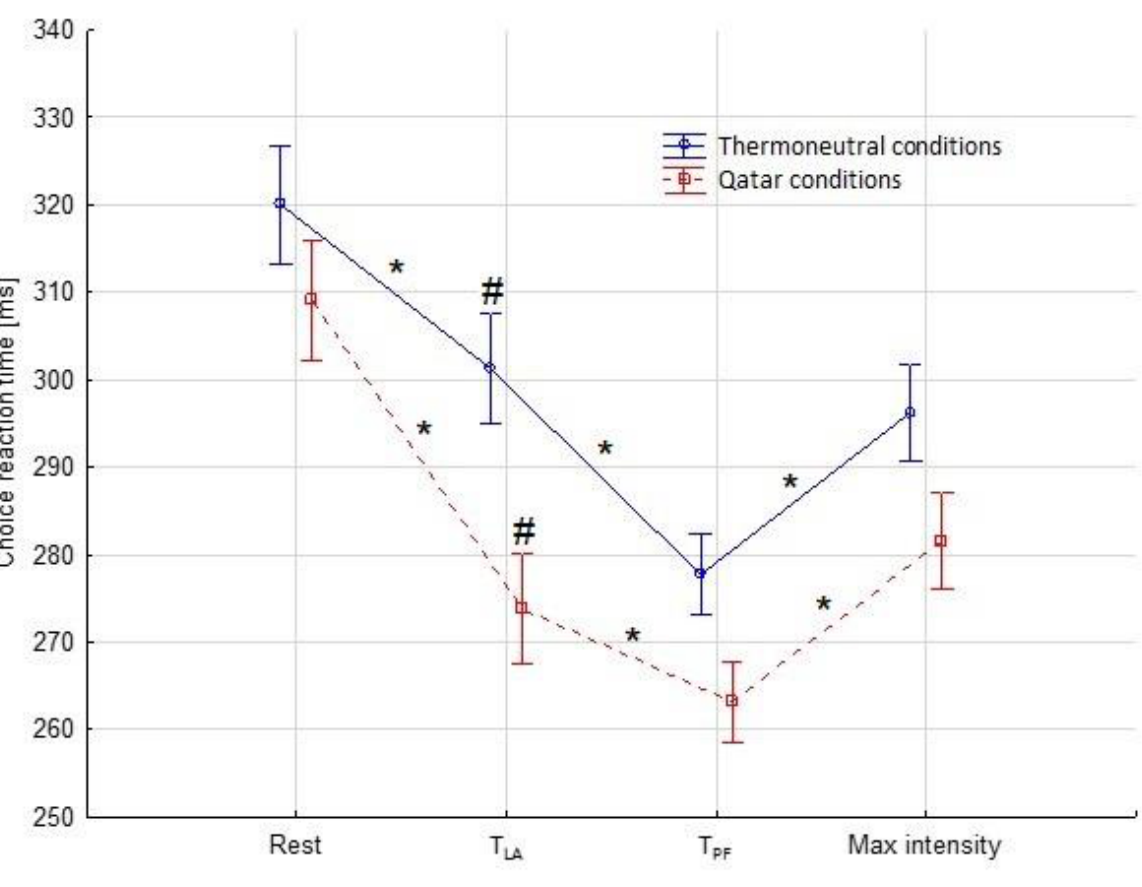
Figure 1. Choice reaction times in subsequent measurement times (means ± SD). Rest—before the incremental exercise test. T LA —lactate threshold. T PF —psychomotor fatigue threshold. Max intensity—maximum load reached during incremental exercise test. * statistical significance between subsequent measurement times in incremental exercise test. # statistical significance between climate